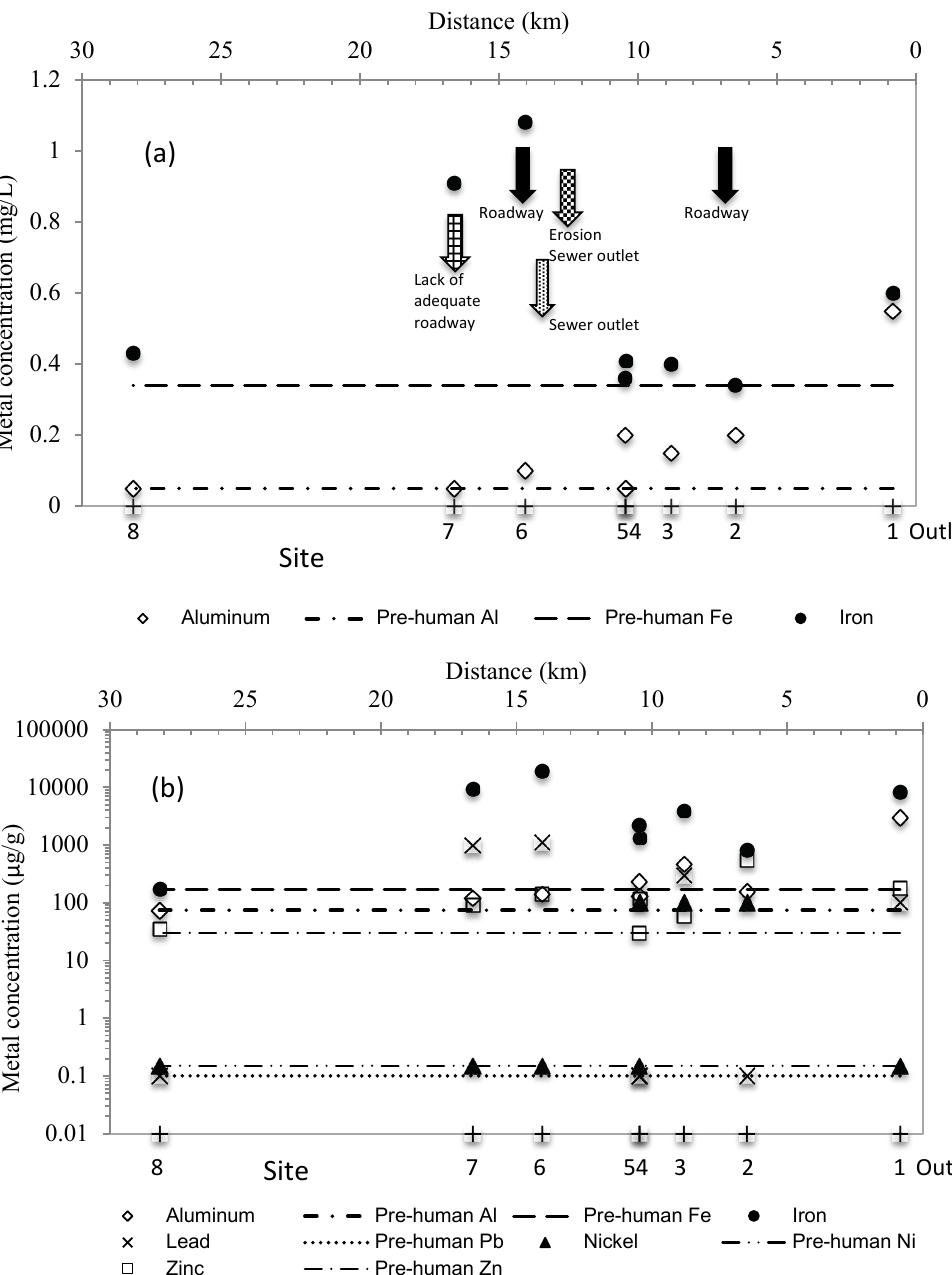
Fig. 1 Metal concentration levels in water (a) and in sediment (b) at eight sites on the Pitimbu River, Brazil. Horizontal lines indicate metals background